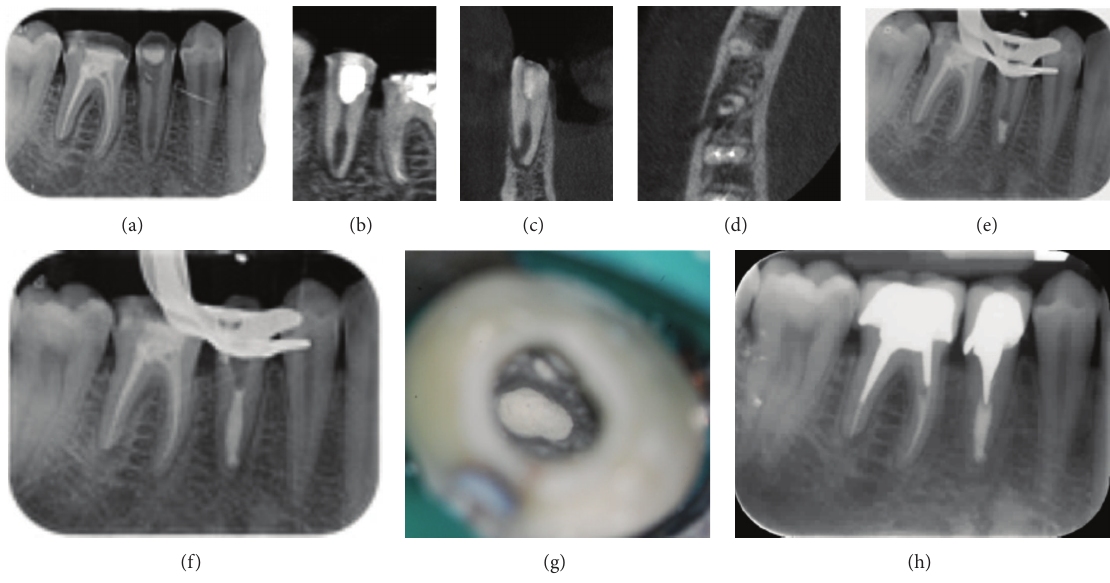
Figure 3: Management of internal root resorption and open apex induced using MTA cement as root canal filling material (tooth 45). (a) Preoperative intraoral radiograph of the second right lower bicuspids showing an abnormal width of the root canal in the third apical part. (b), (c), and (d) Sagittal, coronal, and axial CBCT cross-sections reveal the thickness reduction of radicular walls without perforation but with an open apex in communication with the internal resorbed part of the canal. (e), (f) To avoid an overextension of materials beyond the apex, the apical part of canal, and the resorption lacuna where both filled with MTA. (g) Clinical view with operative microscope of white MTA placed in the third apical part of the canal. (h) Periapical X-ray: control of treatment at one year. Note the absence of periapical disease and the integrity of the